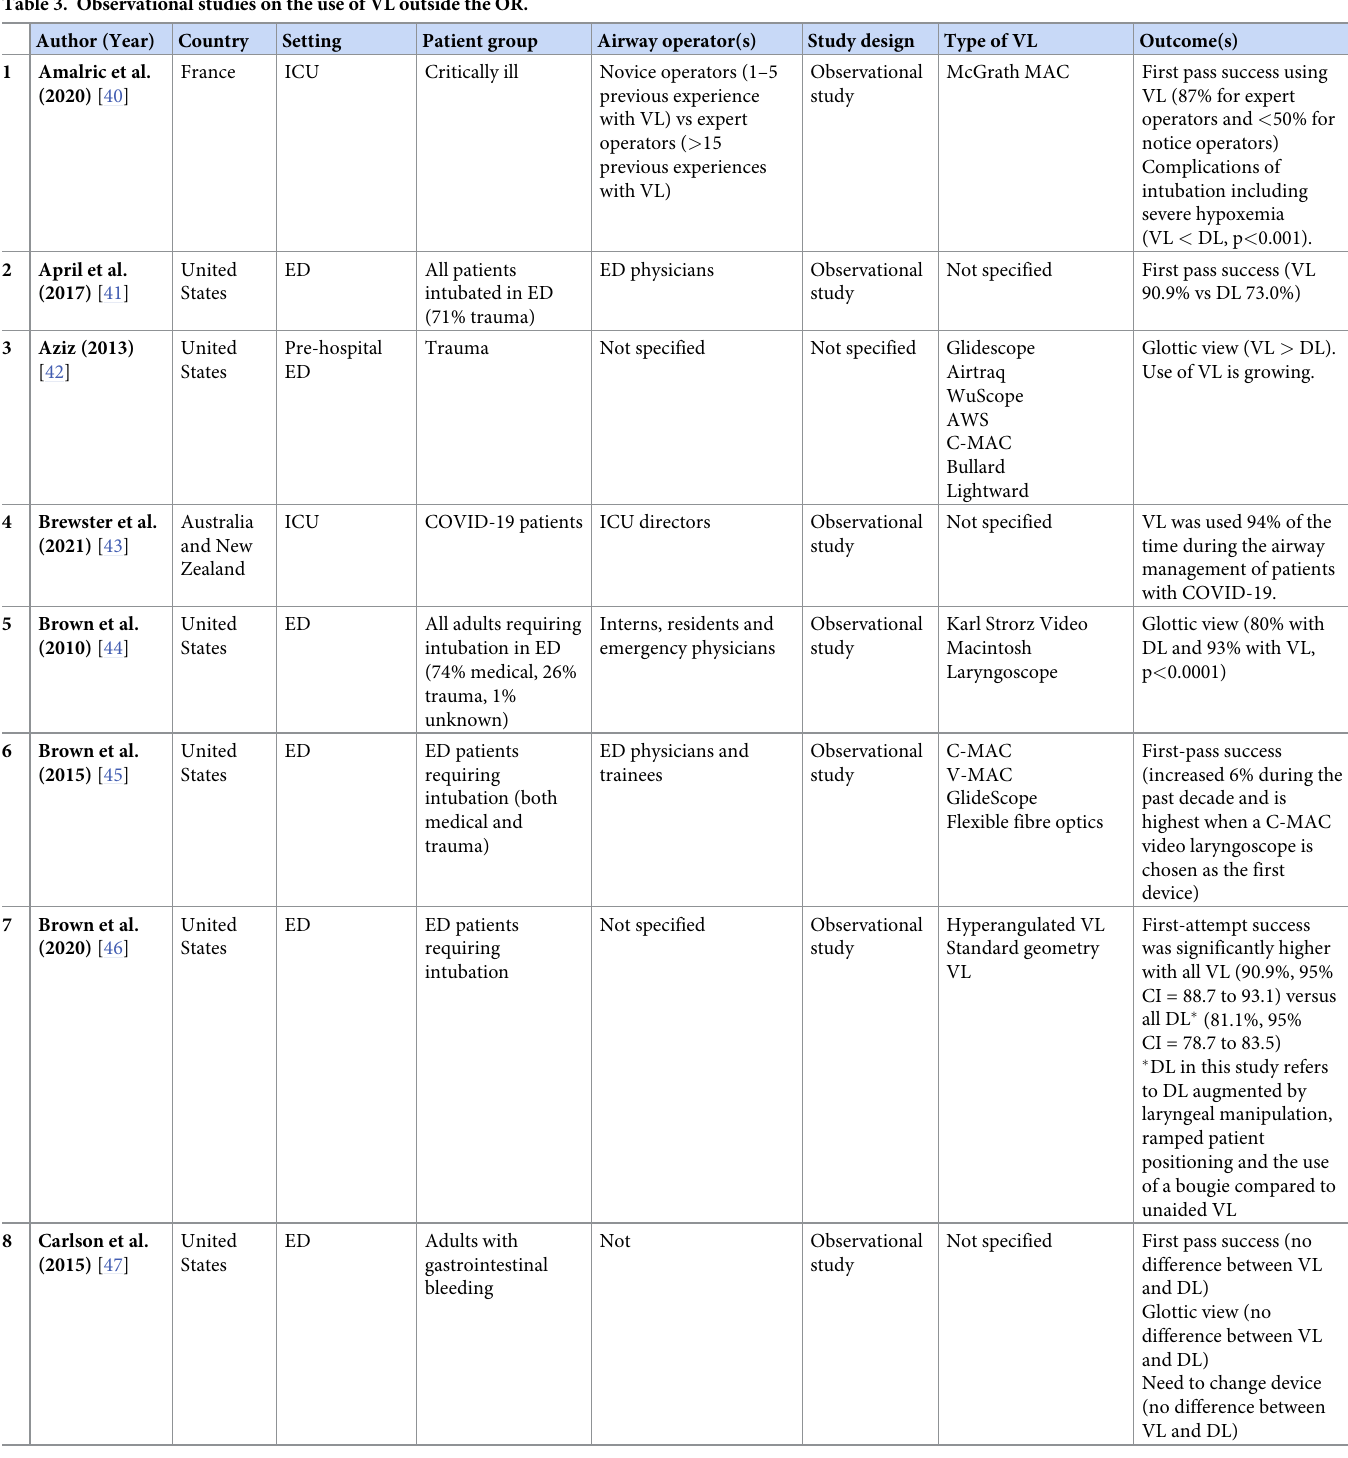
Table 3. Observational studies on the use of VL outside the